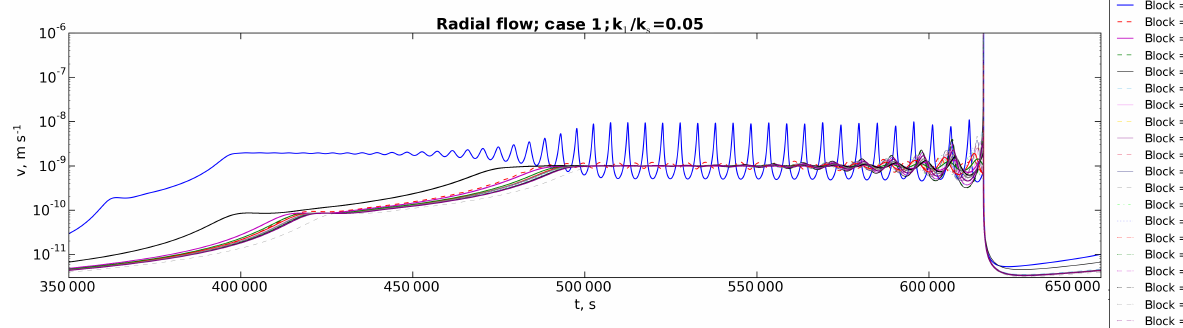
Figure 24. Block velocity variations in time for the system consisting of 20 blocks in Case 1.